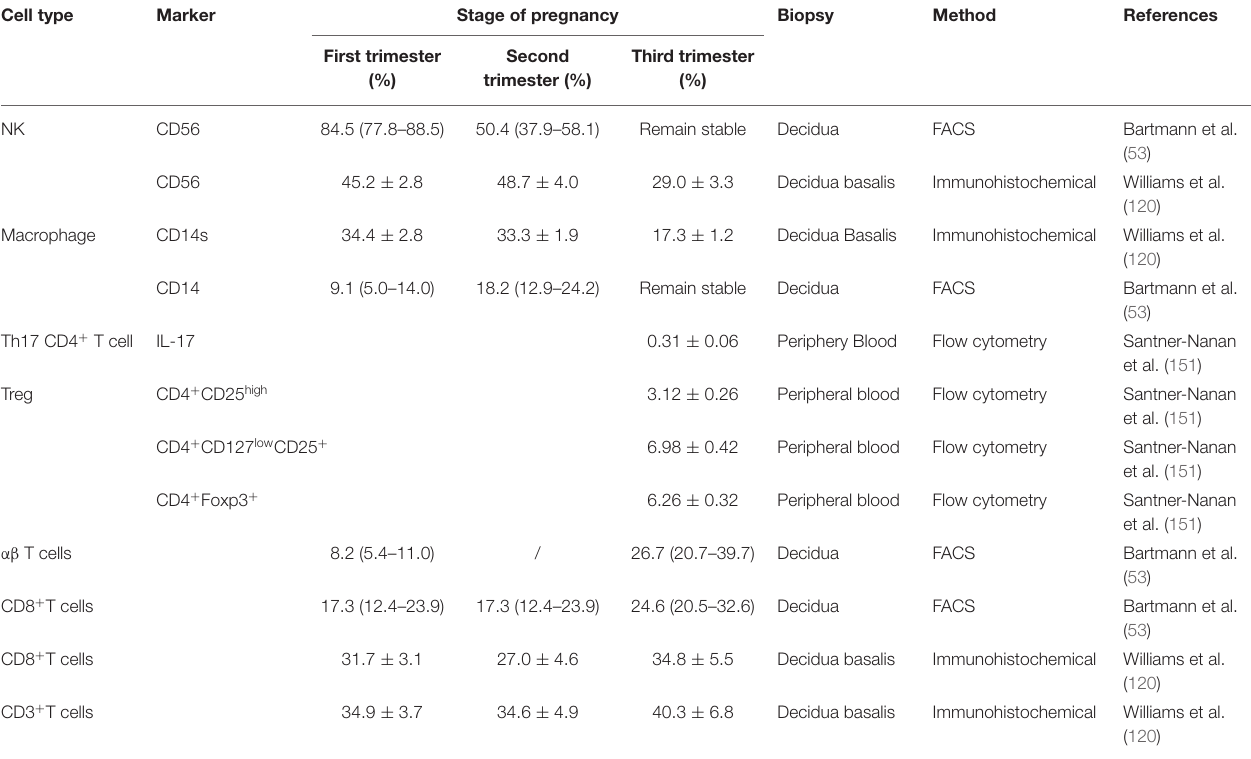
TABLE 2 | Comparison of decidual leukocyte populations between decidua in the first, second, and third trimesters of